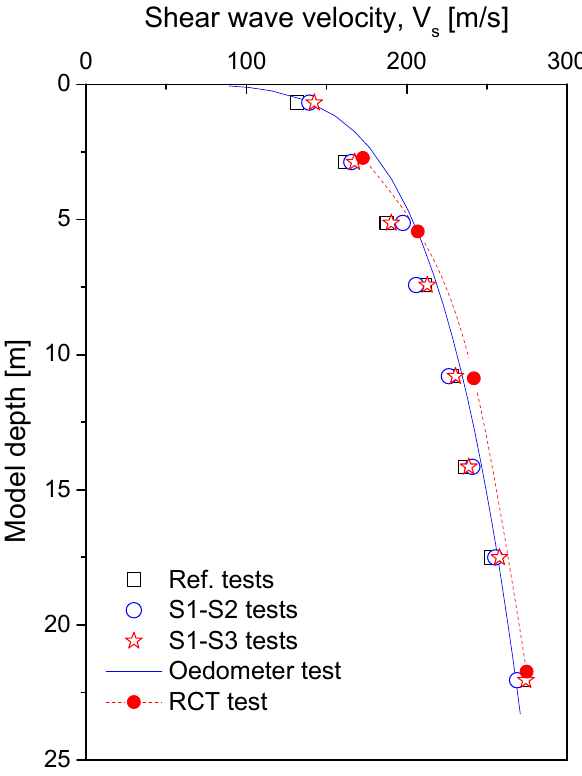
Figure 2. Shear-wave velocity profile of prototype soil in comparison with results from Oedometer and RC (Resonant Column)